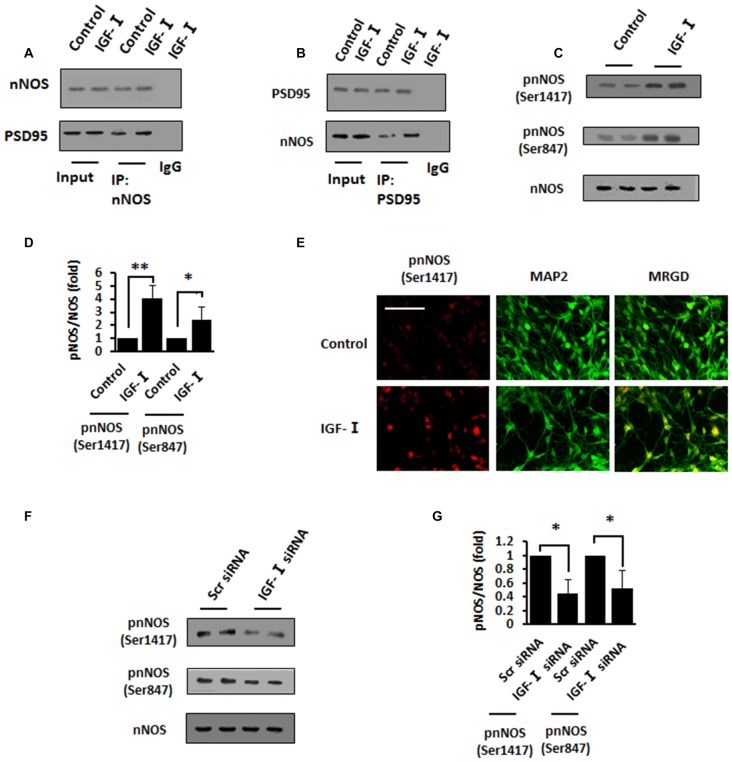
IGF-I triggers phosphorylation of neuronal nitric oxide synthase (nNOS) and destruction of postsynaptic density protein 95 (PSD95)–nNOS interaction in primary hippocampal neurons (PHNs). (A) Immunoprecipitation of lysates of PHNs with IGF-I treatment using control IgG or anti-/nNOS antibodies. Complexes were immunoblotted with anti-PSD95/nNOS antibodies. (B) Immunoprecipitation of lysates of PHNs with insulin treatment with control IgG or anti-PSD95 antibodies. Complexes were immunoblotted with anti-nNOS/PSD95 antibodies. (C,D) IB analysis of lysates of PHNs with IGF-I treatment using anti-pnNOS Ser1417/Ser847 and anti-nNOS antibodies and subsequent densitometry. (E) Double IF staining of PHNs with IGF-I treatment using antibodies against pnNOS Ser1417 (red) and MAP2 (green). (F,G) IB analysis of lysates of PHNs after IGF-I siRNA transfection using anti-pnNOS Ser1417/Ser847 and anti-nNOS antibodies and subsequent densitometry. Data are shown as mean ± SD. *P < 0.05, **P < 0.01. Scr, scramble. Scale bar, 25 μm. MRGD, merged image.